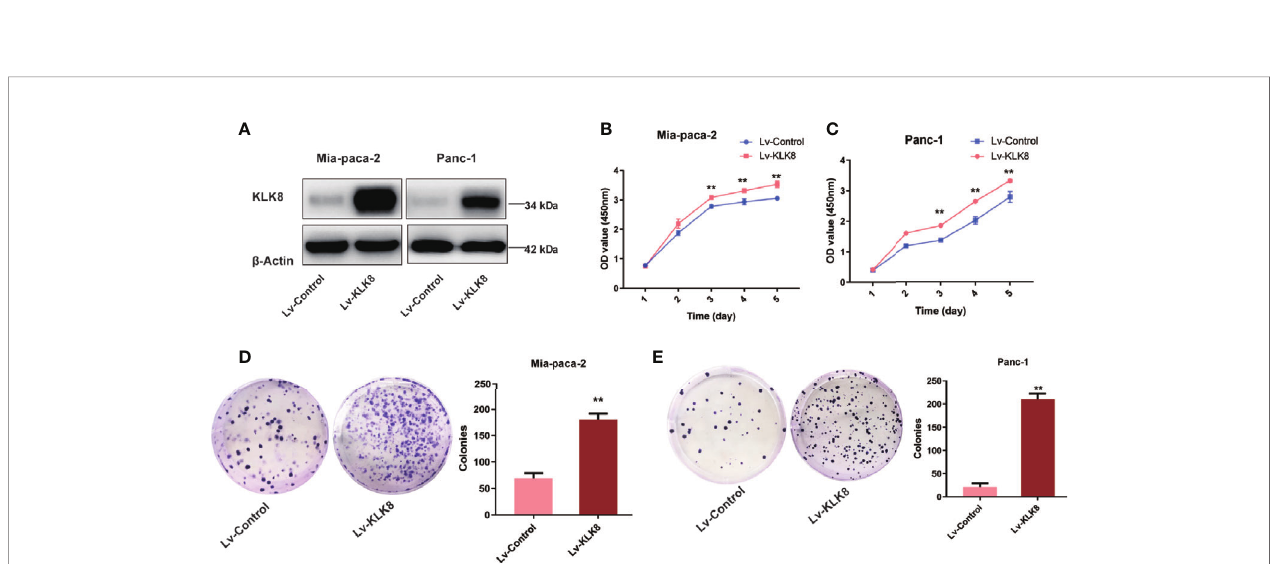
FIGURE 3 | KLK8 overexpression promoted the proliferation of PDAC cells. KLK8 overexpression was induced with recombinant Lentivirus infection (Lv-KLK8) in human pancreatic cancer cell lines Mia-paca-2 and Panc-1, and an empty adenovirus served as control (Lv-Control). (A) Mia-paca-2 and Panc-1 cells transfected with KLK8 overexpression vectors were validated at protein level by western blot analysis. (B, C) Cell proliferation was detected by CCK8 Assay in Mia-paca-2 (B) and Panc-1 (C) cells. (D, E) Colony formation was detected in Mia-paca-2 (D) and Panc-1 (E) cells. Data were presented as the mean ± SEM (n=3). **p < 0.01 vs